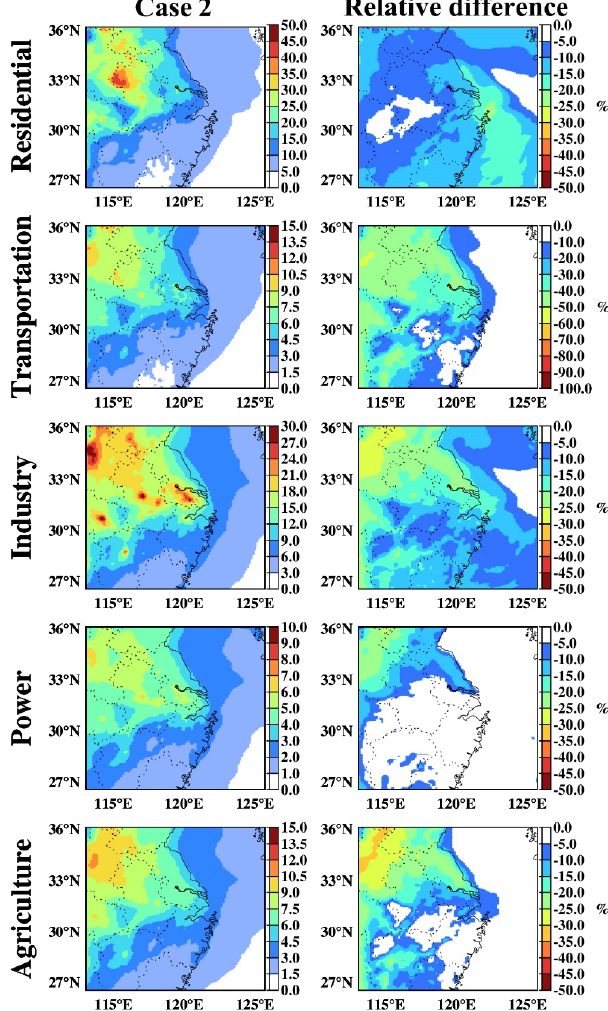
Figure 4. Predicted PM 2 . 5 from different source sectors of two cases, and the relative difference in the YRD from 23 January to 28 February 2020. Note that the color ranges are different among